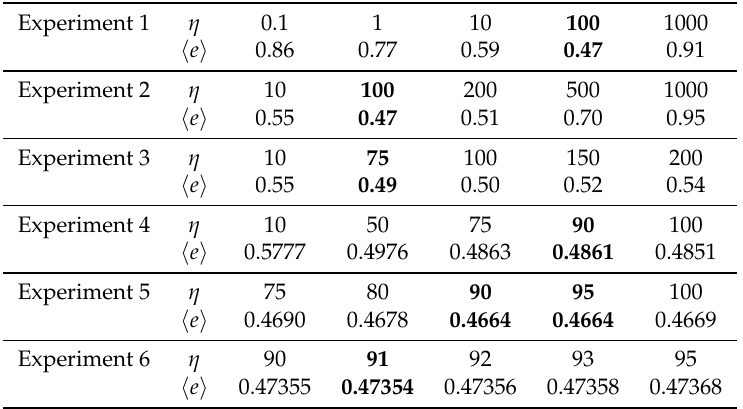
Table A3. Results of the experiments to identify the almost optimum value of η giving the smallest (cid:104) e (cid:105) when Correlation is Accounted for